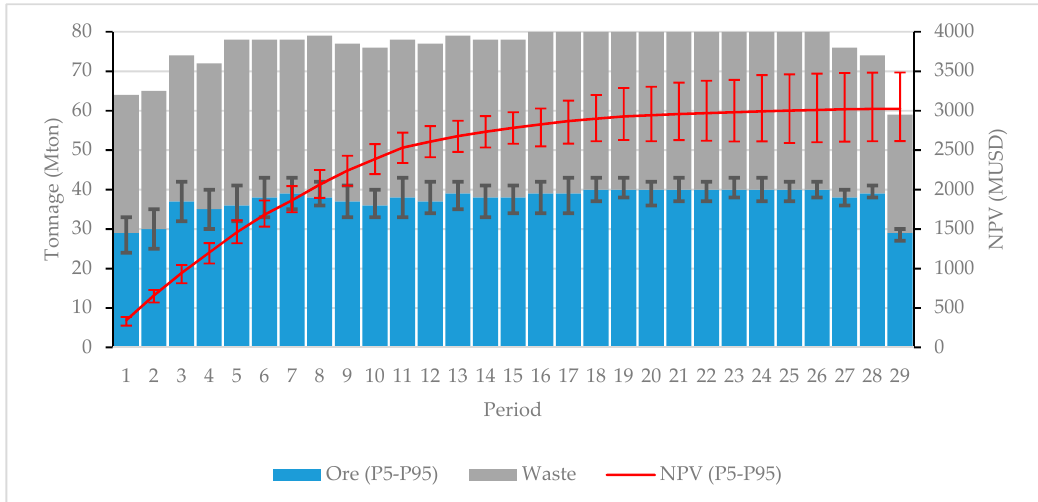
Figure 13. Ore and waste tonnages and net present value from production schedules obtained according (STO) by using scheduling Scheme 2. Results are re-evaluated by using scheduling Scheme 3 for fair comparison.